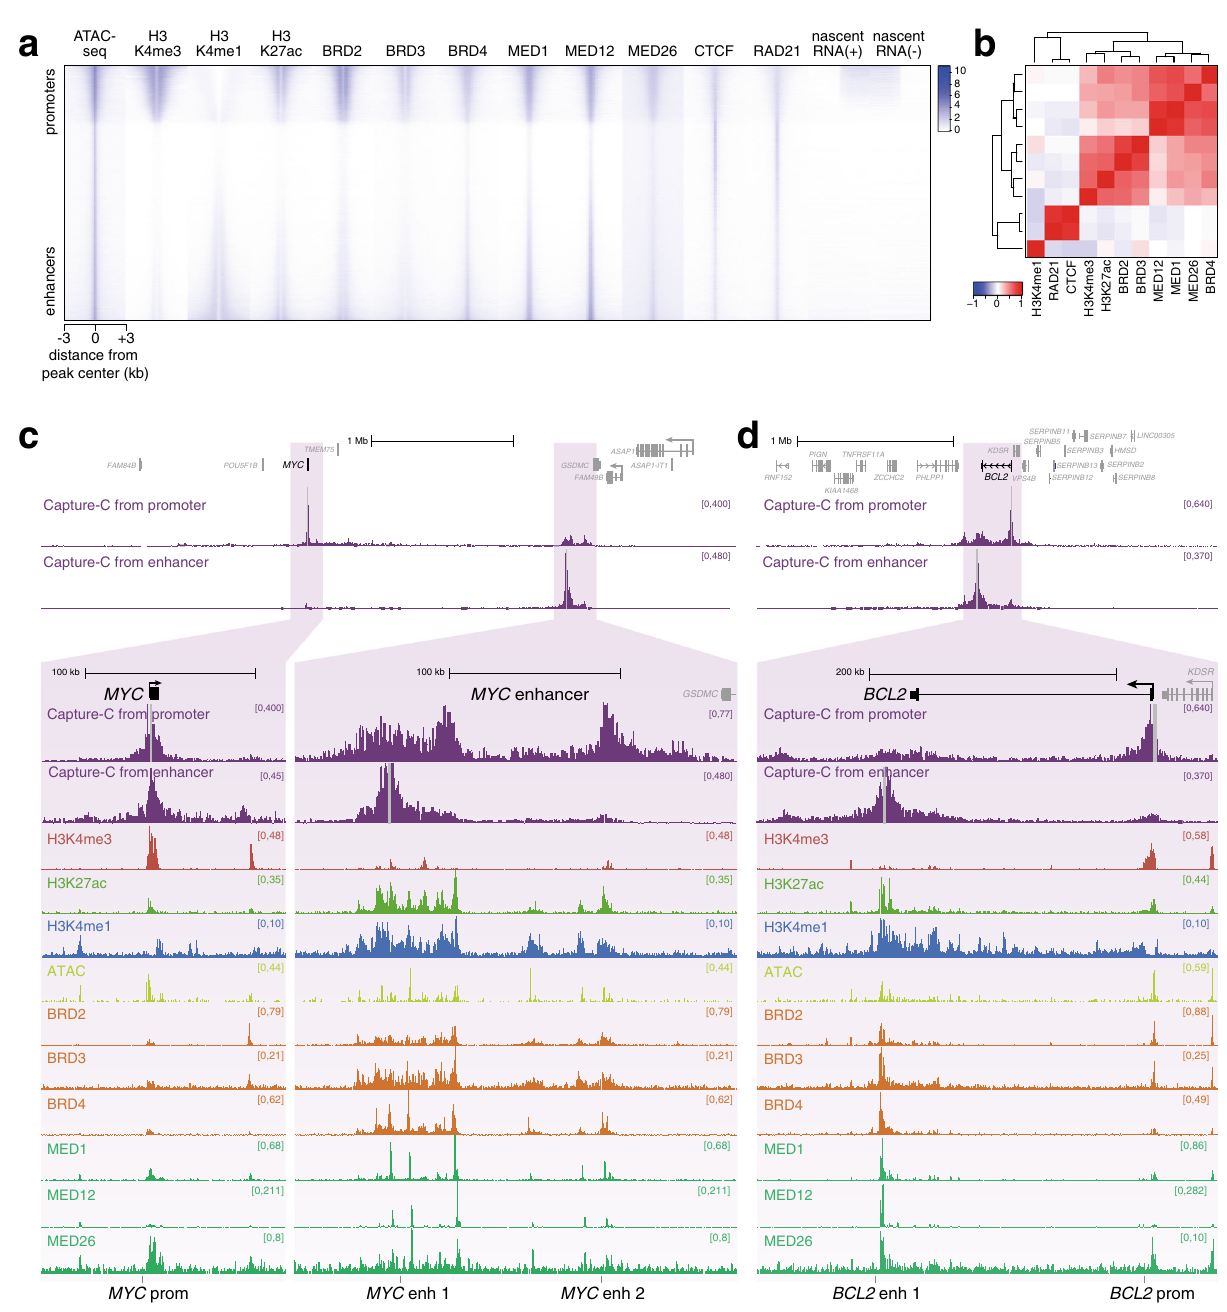
Fig. 1 BET proteins and Mediator are a key feature of enhancers. a Heatmap comparing levels of histone modi fi cations, chromatin proteins and stranded nascent RNA-seq at ATAC-seq peaks in SEM cells. Peaks are ranked based on the relative levels of H3K4me3 and H3K4me1, placing promoter-like ATAC- seq peaks towards the top and enhancer-like ATAC-seq peaks towards the bottom. b Pearson correlation coef fi cients for ChIP-seq data at ATAC-seq peaks shown in a . Dendrogram shows hierarchical clustering of datasets. Source data are provided as a Source Data fi le. c Capture-C, ChIP-seq and ATAC- seq at the MYC gene and enhancer region in SEM cells. Capture-C was conducted using the MYC promoter or enhancer region as the viewpoint, indicated by vertical gray bars, and is displayed as the mean of three biological replicates. Locations of primers used for BRD4/Mediator ChIP-qPCR are shown at the bottom of the fi gure. d Capture-C, ChIP-seq, and ATAC-seq data at BCL2 , as in c (Bromodomain and Extra-Terminal domain) proteins and comparable to the distribution of H3K27ac (Fig. 1a, Supple- Mediator subunits at ATAC peaks genome-wide in the leuke- mentary Fig. 1a). Consistent with the idea that BRD4 physically mia cell line SEM, with peaks ranked by the relative levels of interacts with Mediator 44 – 47 , BRD4 binding positively correlated with all three Mediator subunits at ATAC peaks H3K4me3 and H3K4me1, thereby separating promoter (top of (Fig. 1b). In contrast, although they appear to overlap at a heatmap) and enhancer (bottom of heatmap) loci (Fig. 1a). subset of loci (Fig. 1a), CTCF and the cohesin subunit RAD21 BET-domain proteins (i.e., BRD2, BRD3, and BRD4) and clustered separately from BRD4/Mediator (Fig. 1b), showing Mediator subunits MED1, MED12, and MED26 all showed a distinct distribution at ATAC peaks, with similar levels an enrichment at both promoter and enhancer ATAC peaks,